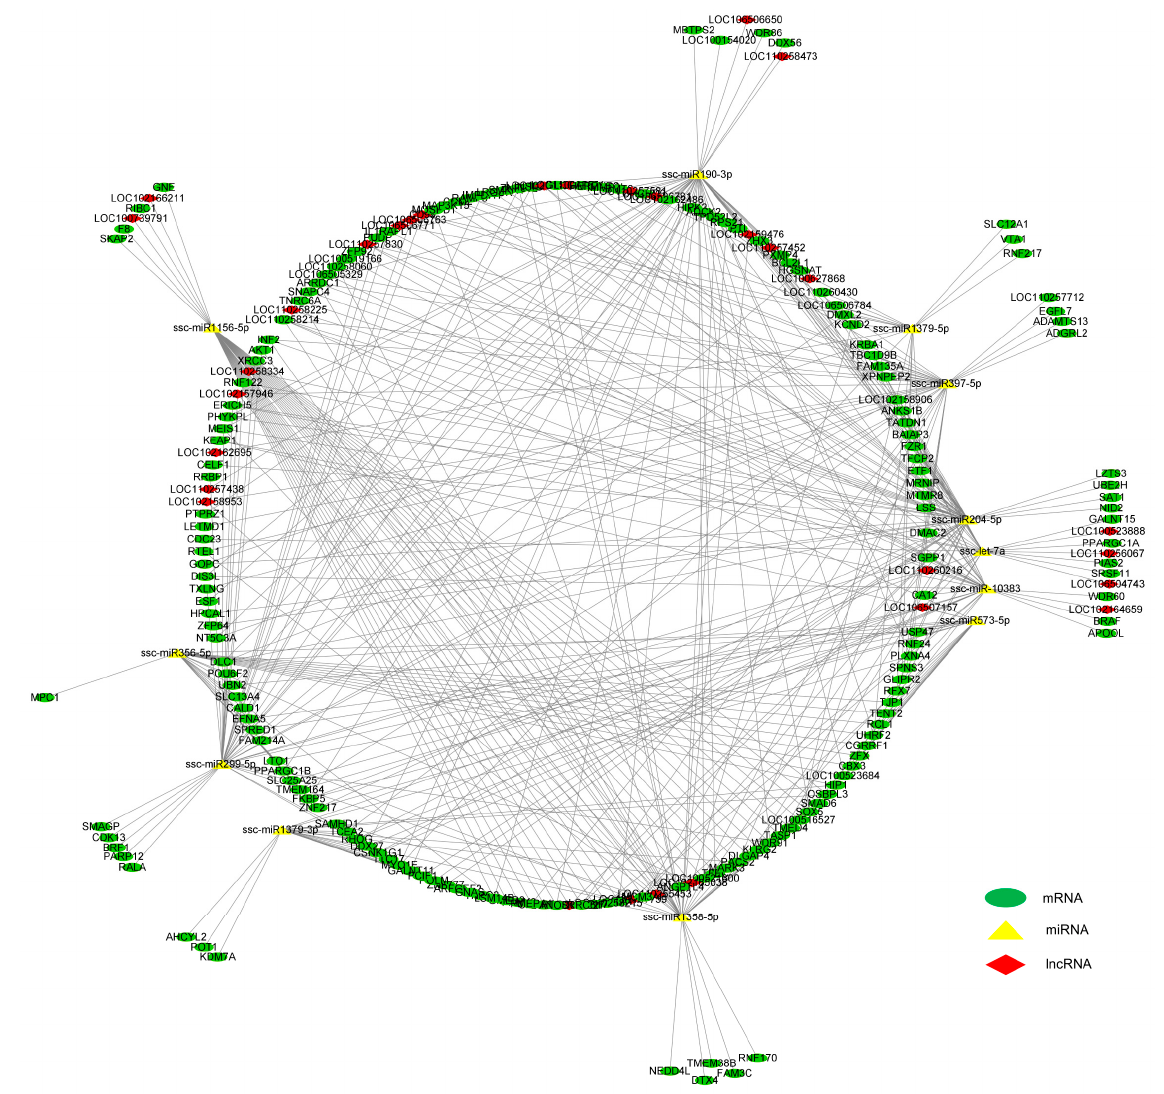
Figure 7. mRNA–miRNA–lncRNA regulatory networks in the Longissimus dorsi muscle of pigs. Green circulars indicate mRNAs, red diamonds indicate lncRNAs, yellow triangles indicate miRNAs, and the lines represent the targeting interactions between